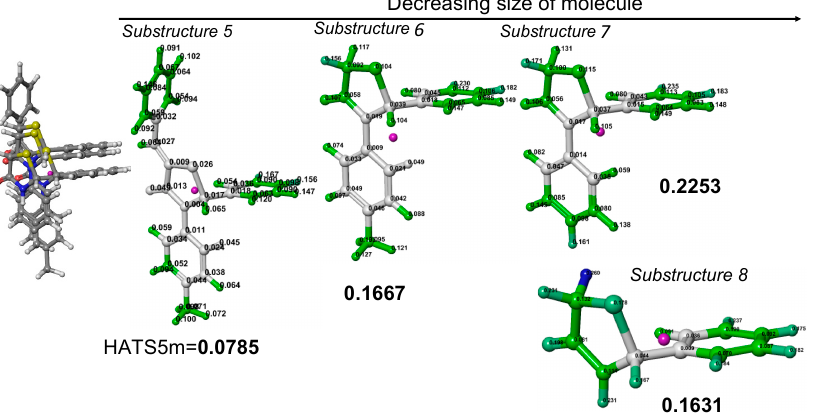
Figure 11. Illustration of the effect of reducing molecule size on increasing leverage scores and changes in HATS5m value. Each atom in the molecular structure has a label with a leverage value. Color highlighting indicates atoms with high (blue), medium (green), and low (white) leverage scores.